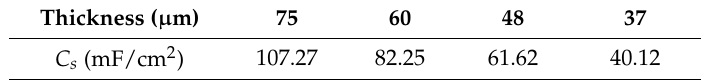
Table 3. Specific capacitances at different scan rates. PVA-KOH = Polyvinyl alcohol-potassium hydroxide.